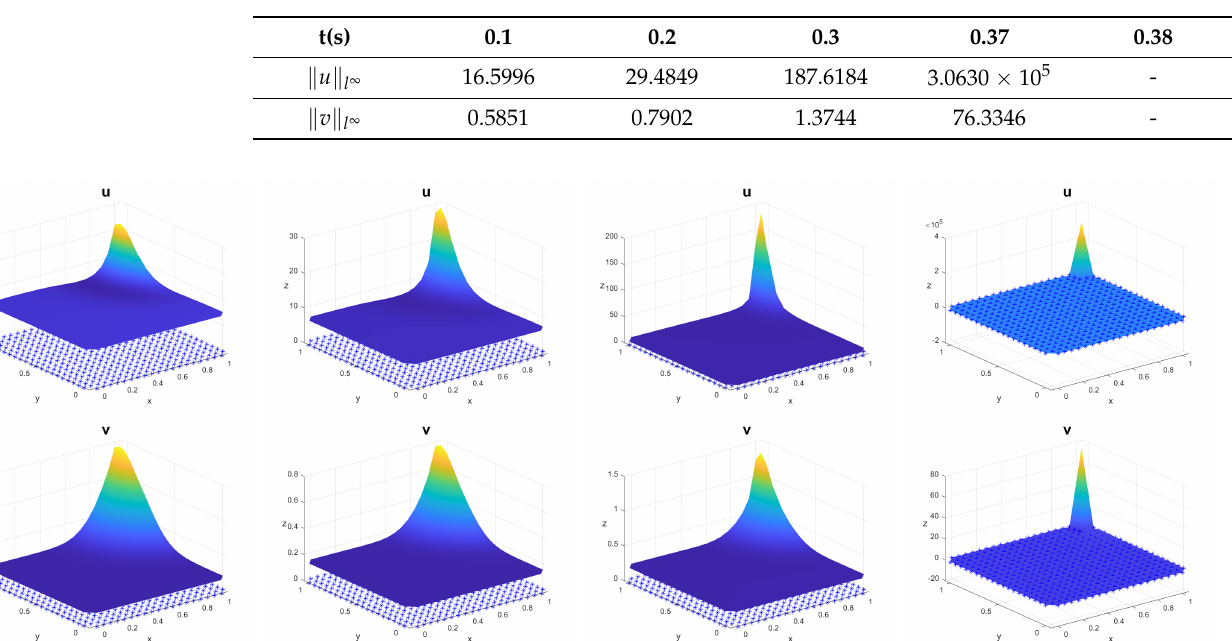
Table 2. Values of the asymptotic solutions and l ∞ norms of the numerical solutions in the example 2.